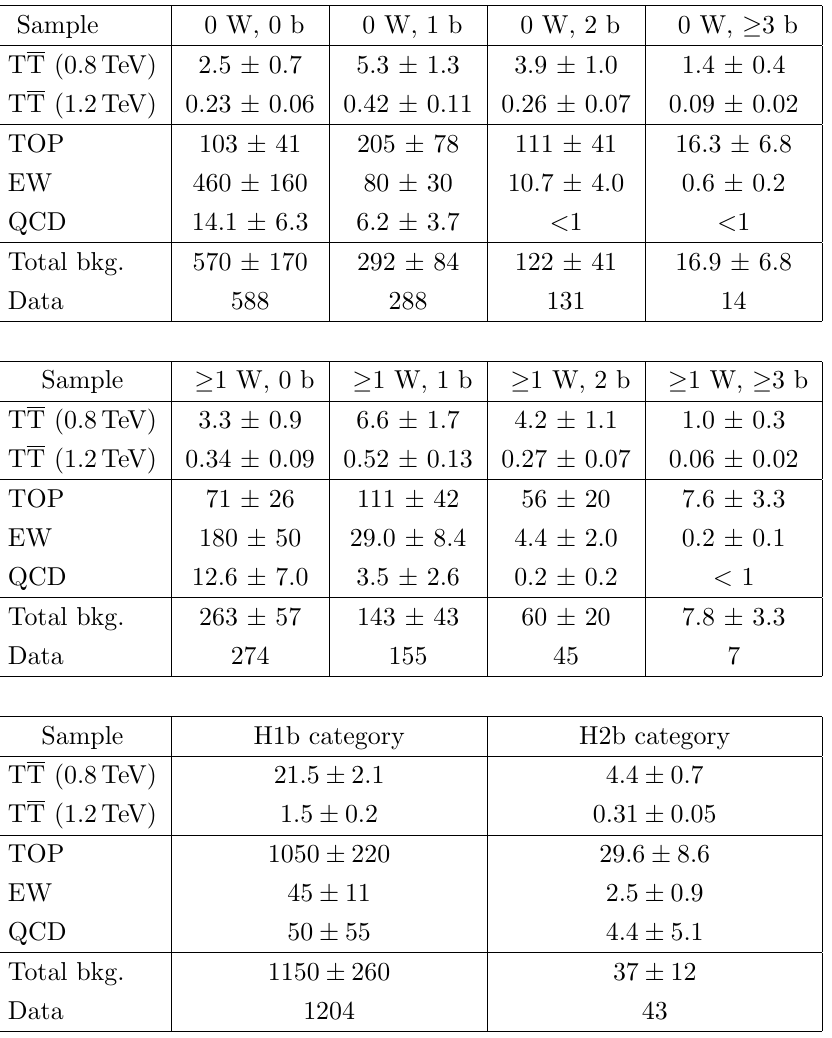
Table 4 . Number of events in each category after combining the electron and muon channels. Uncertainties include statistical and systematic components from table 2, with uncertainty in the total background yield accounting for correlations across background processes. Yields of TT signal assume the theoretically predicted production cross section within the singlet branching fraction